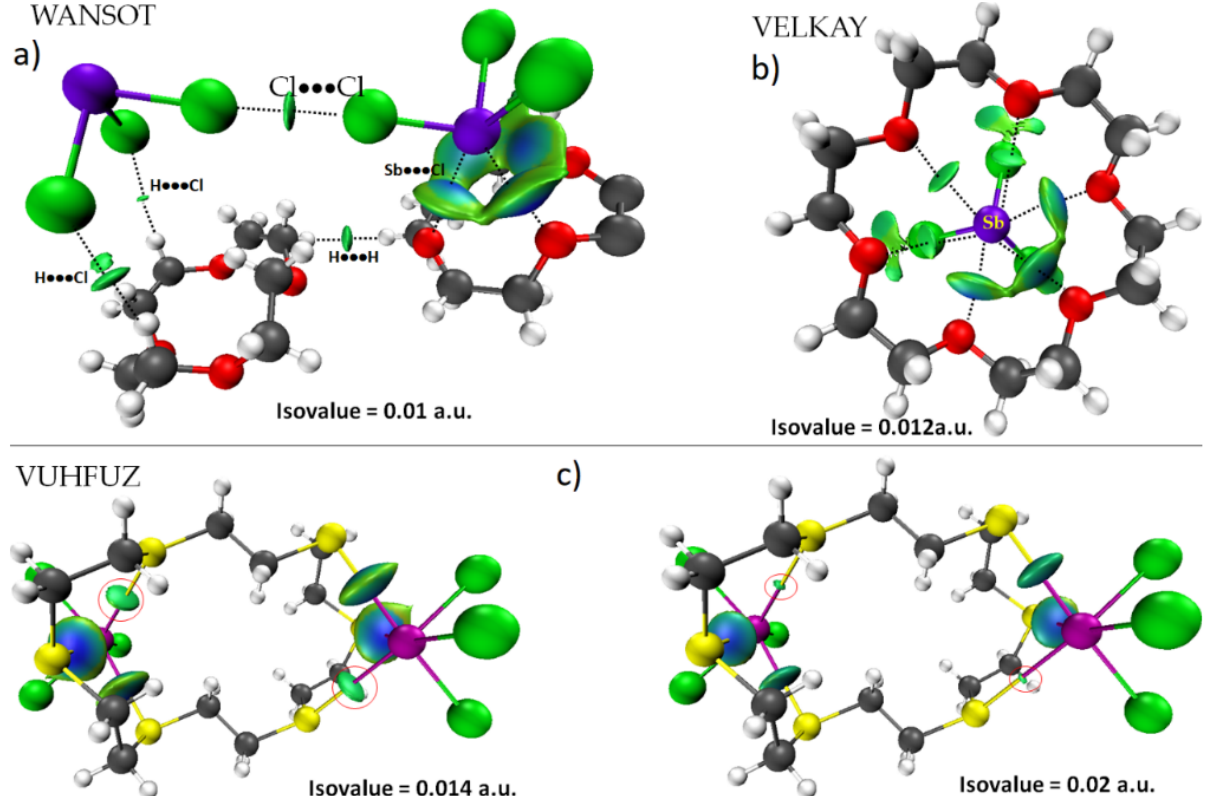
Figure 27. IGM- δ g based isosurface plots for ( a ) (12-crown-4)SbCl 3 , ( b ) (18-crown-6)SbCl 3 and ( c ) (18-S-6)(SbCl 3 ) 2 . The isosurface plots in ( c ) were obtained with two different isovalues.